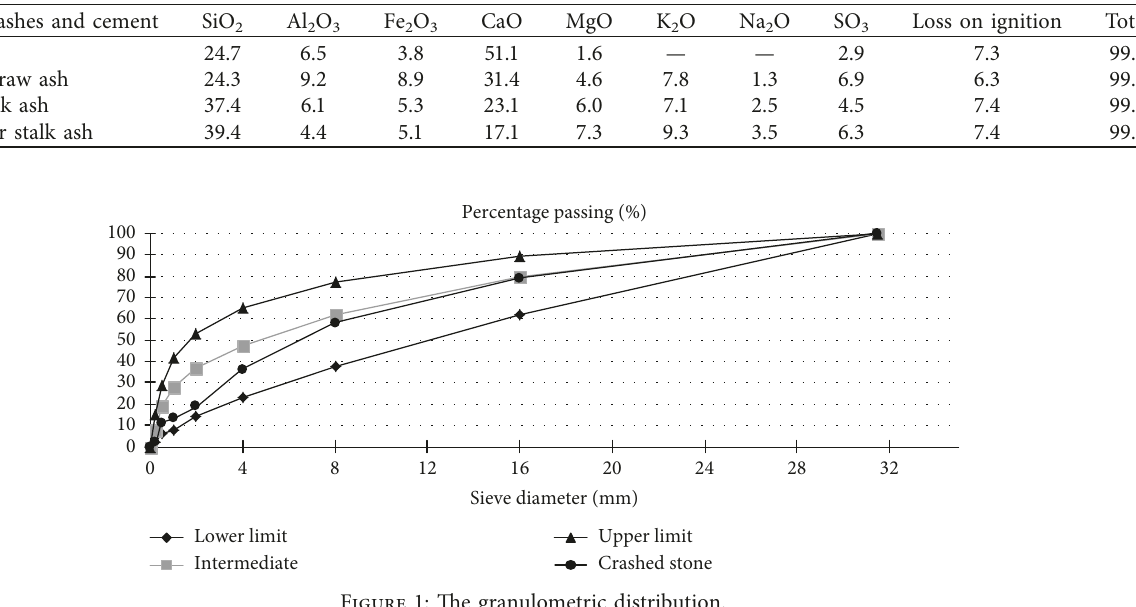
Table 1: Chemical components of the cement and organic ashes (% by weight).